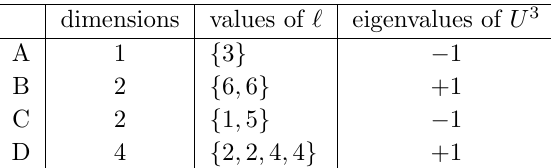
Table 2 . The values of ‘ and eigenvalues of U 3 for physical solutions of BAE with M = 6 ; K = 2 in the four subspaces under primary decomposition. All the solutions in the same subspace have the same eigenvalues of U 3